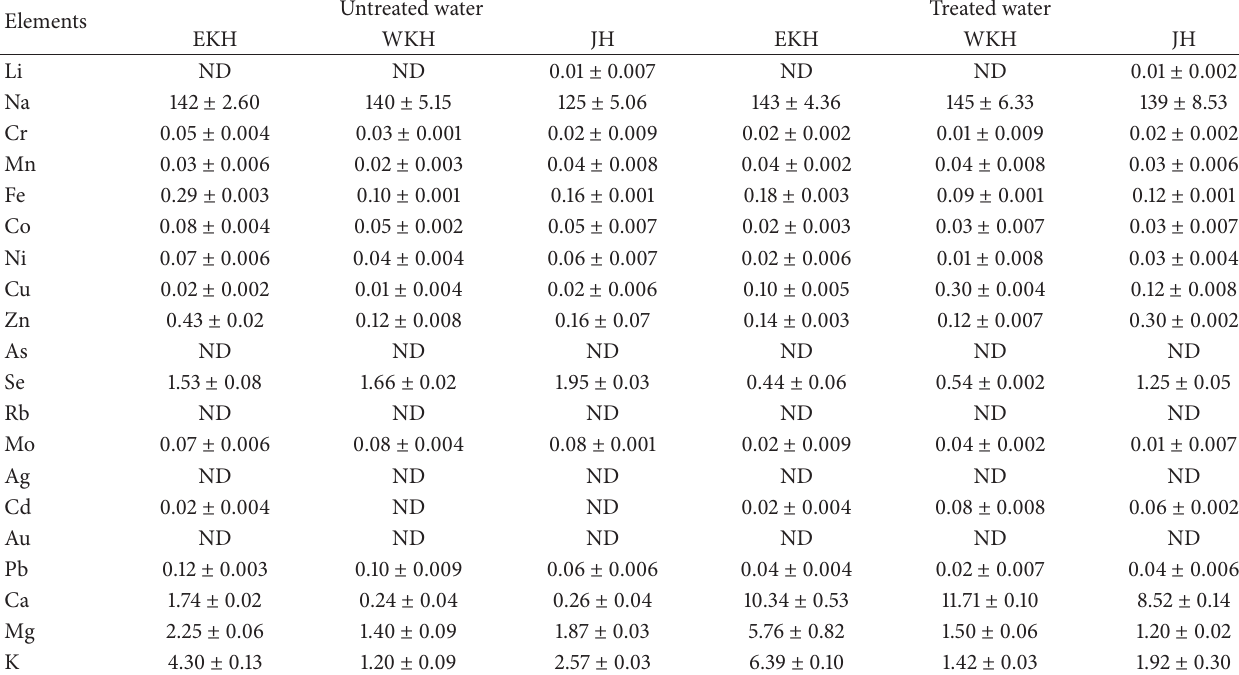
Table 3: Concentrations of trace elements in ppm found in (raw) untreated and treated